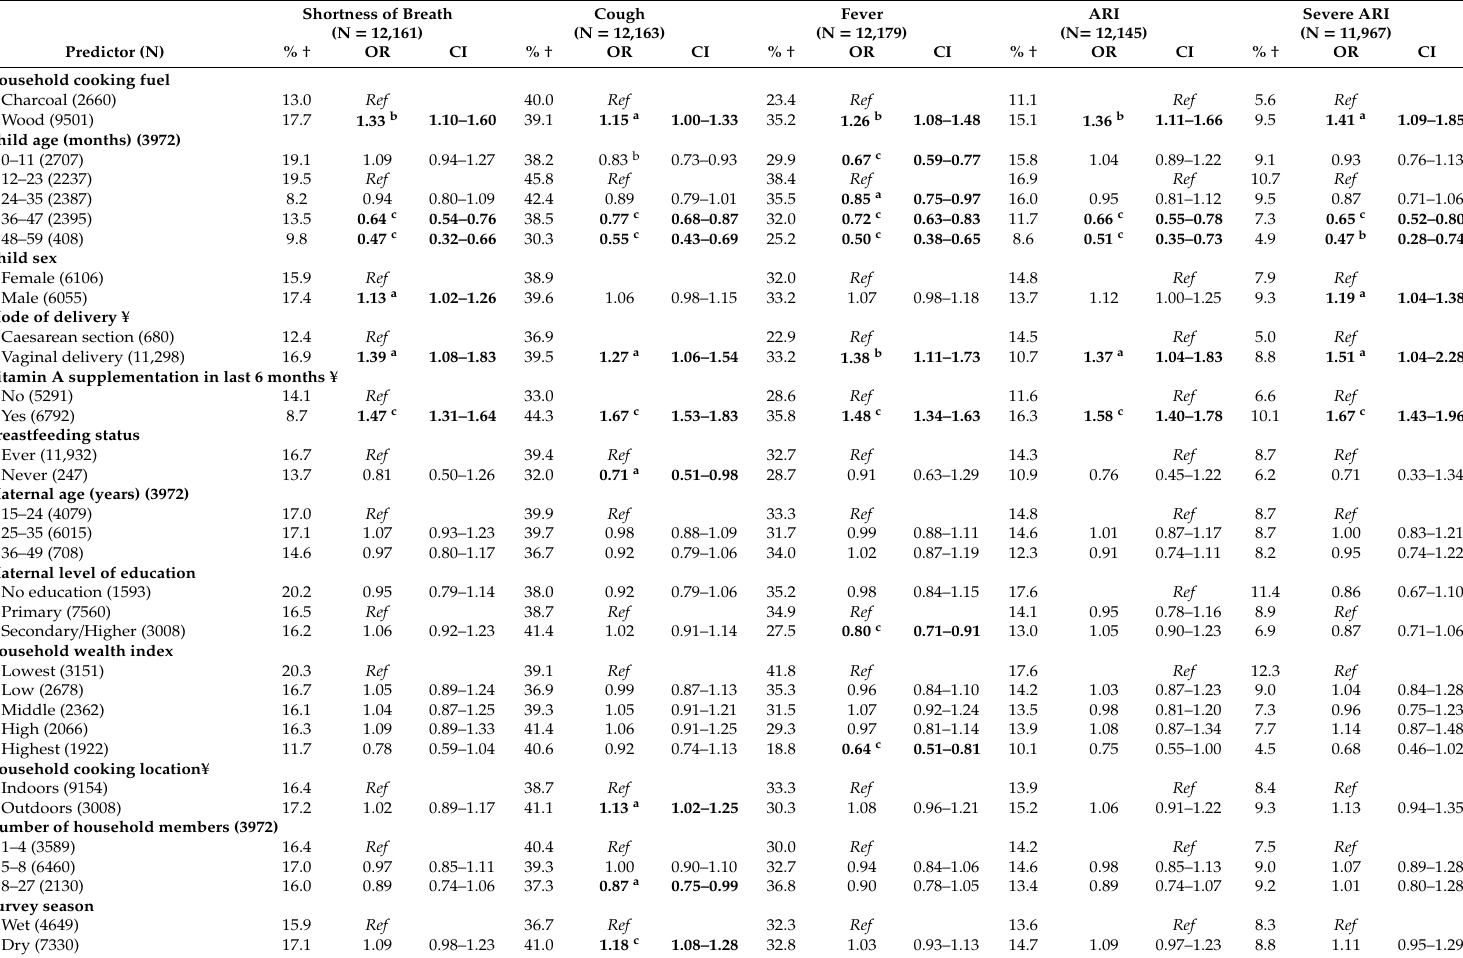
Table 2. Adjusted Logistic regression analysis for the whole study population (N =